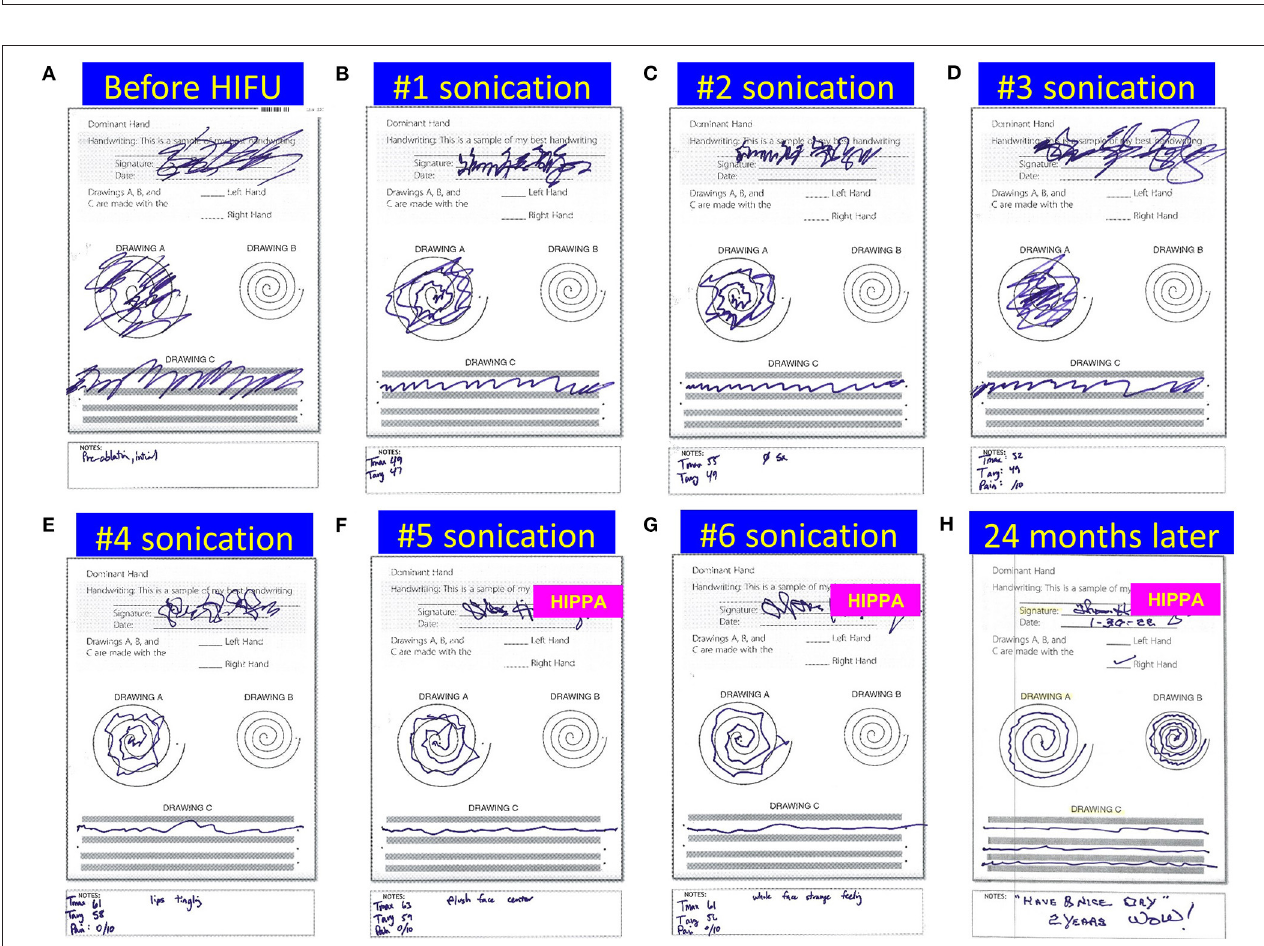
FIGURE 6 | Drawings from a patient with essential tremor during MRgFUS left thalamotomy. The patient’s handwriting, spiral, and line drawing were checked after each sonication in their supine position inside the MR suite (A–G) , and we received 2-year follow-up mail of handwriting sheet from the patient (H) . Note the handwriting of the patient’s name after HIFU has been blocked for deidentification purposes because it is now sharp enough to read. of movement disorders. The benefits of this treatment are